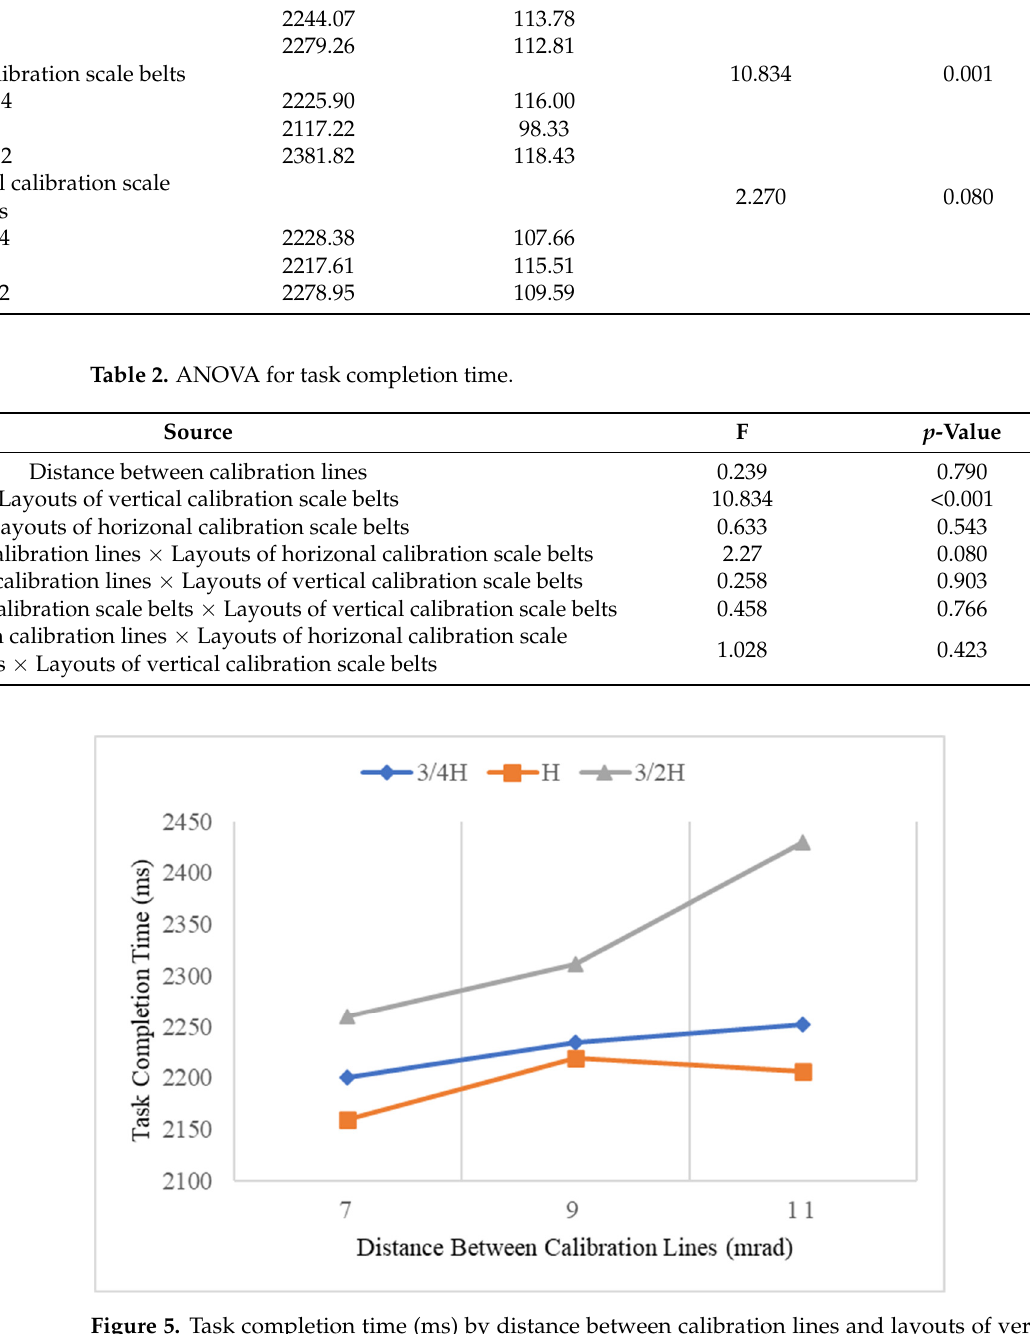
Figure 5. Task completion time (ms) by distance between calibration lines and layouts of vertical calibration scale belts.